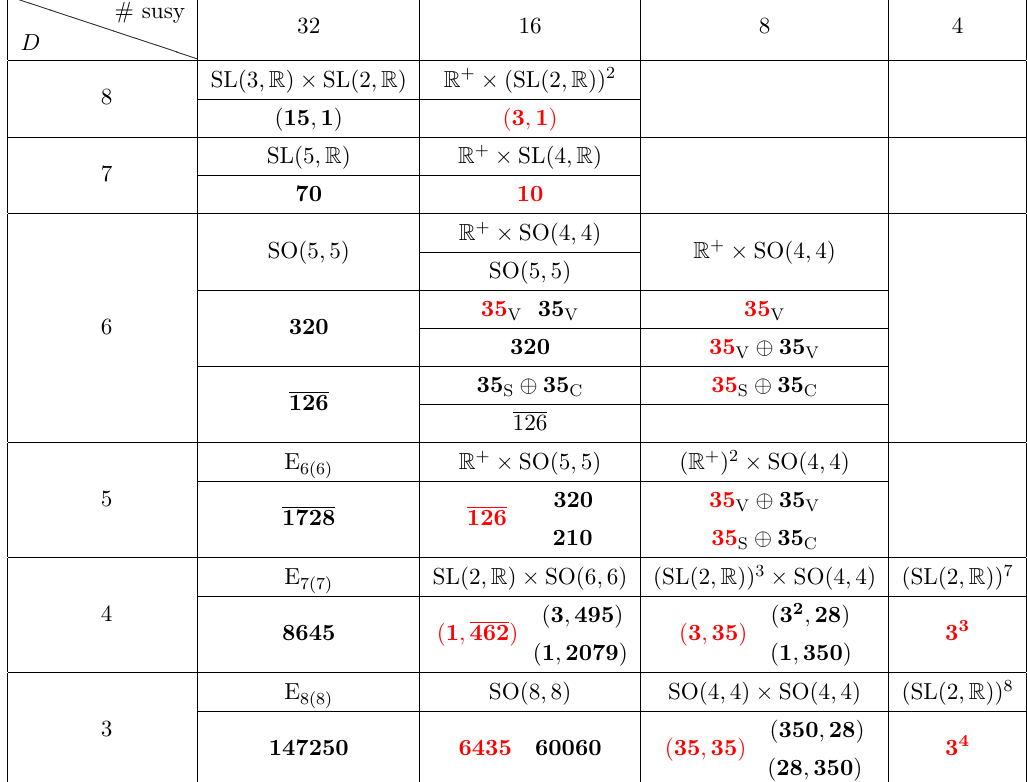
Table 11 . The representations of the space-(cid:12)lling branes that preserve the same supersymmetry of the truncation (in red) and those that are 1/2-BPS states (in black). In six dimensions the case with 16 supersymmetry is divided in two rows, with the upper row corresponding to the 6A and the lower row to the 6B truncation. In four dimensions, the representations of the cases with eight and four supersymmetry are written in a short-hand notation which stands for eqs. (3.13) and (3.14) (eight supersymmetries) and (3.21). Similarly, in three dimensions the red representations of the theory with eight supersymmetries are given in eqs. (3.17), while those of the theory with four supersymmetries can be derived from